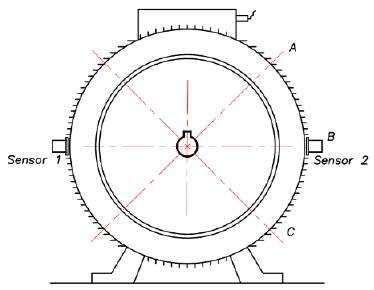
Figure 20. Illustration of the 3 measured positions of the sensors around the machine. Then, when the obtained results give at least one position with opposed magnitude variations with the load, then a fault can be suspected. AI methods can be also used to limit the number of measurements